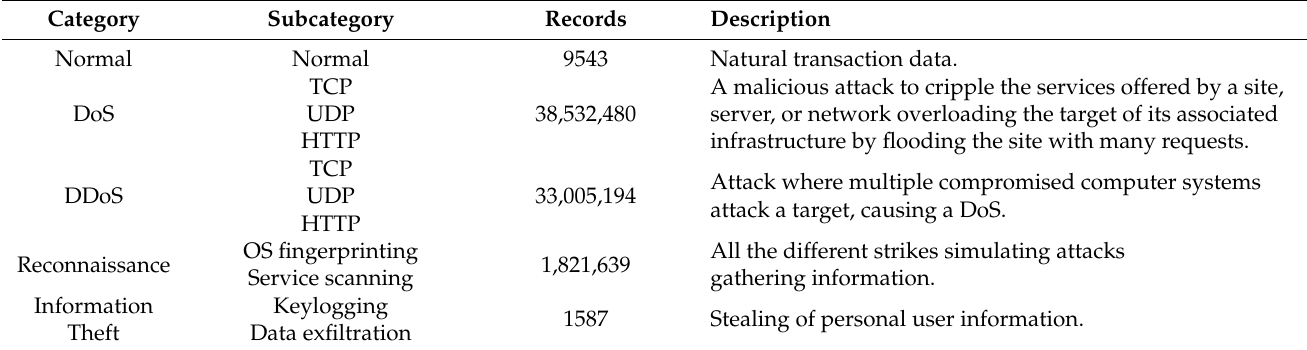
Table 2. BoT-IoT